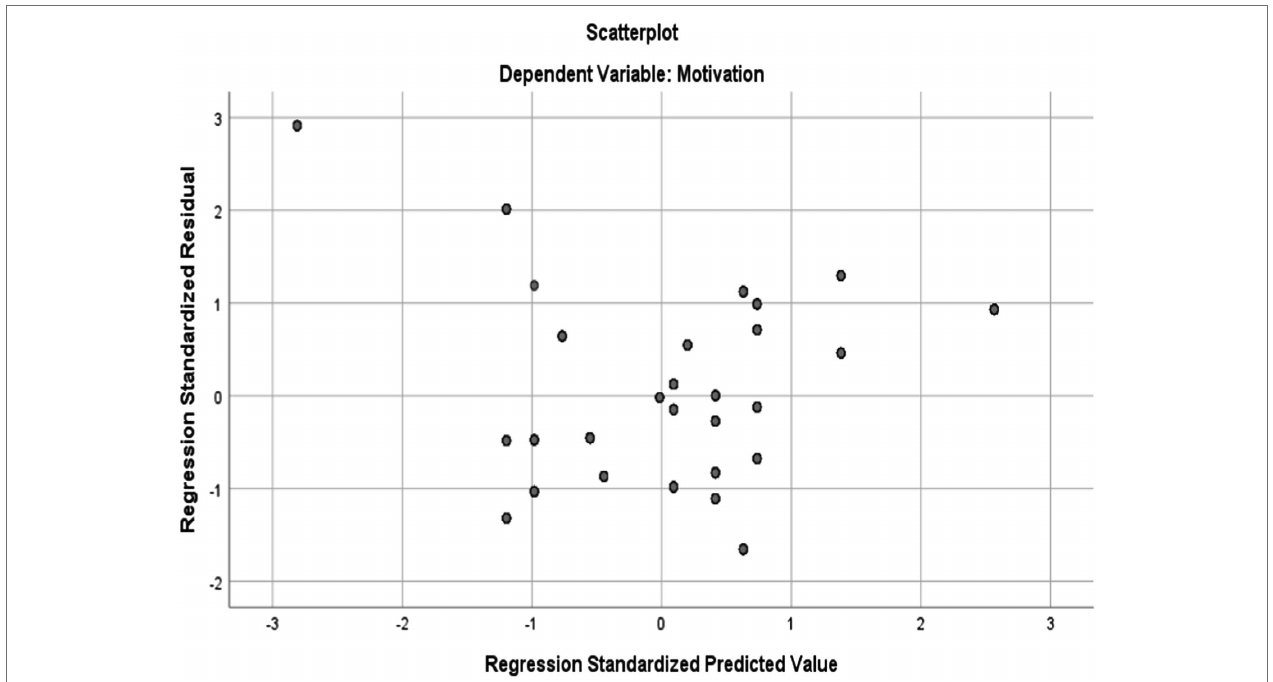
FIGURE 4 | Scatter plot with teachers’ motivation as dependent variable.